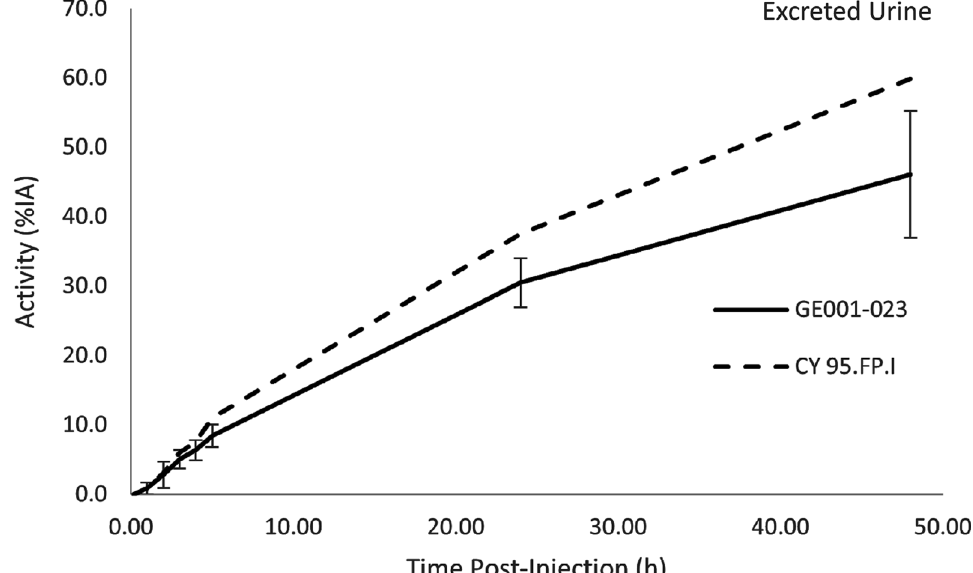
Fig. 2 Mean excreted urine 123 I activity curves in Chinese HVs (solid line, GE001-023, with error bars at one standard deviation) vs the HVs in a European phase 1 study (dashed line, CY95.FP.1) [8]. % IA percentage of injected activity; h